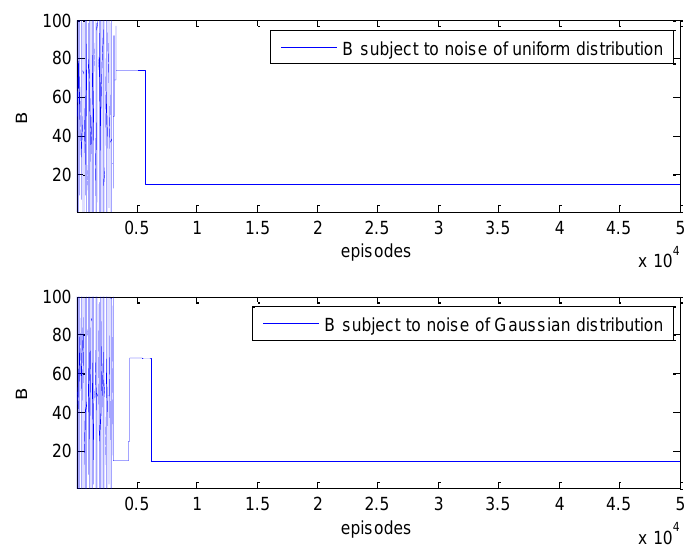
Figure 7. The episode training process with leakage of 0.01 ( B r = 15).